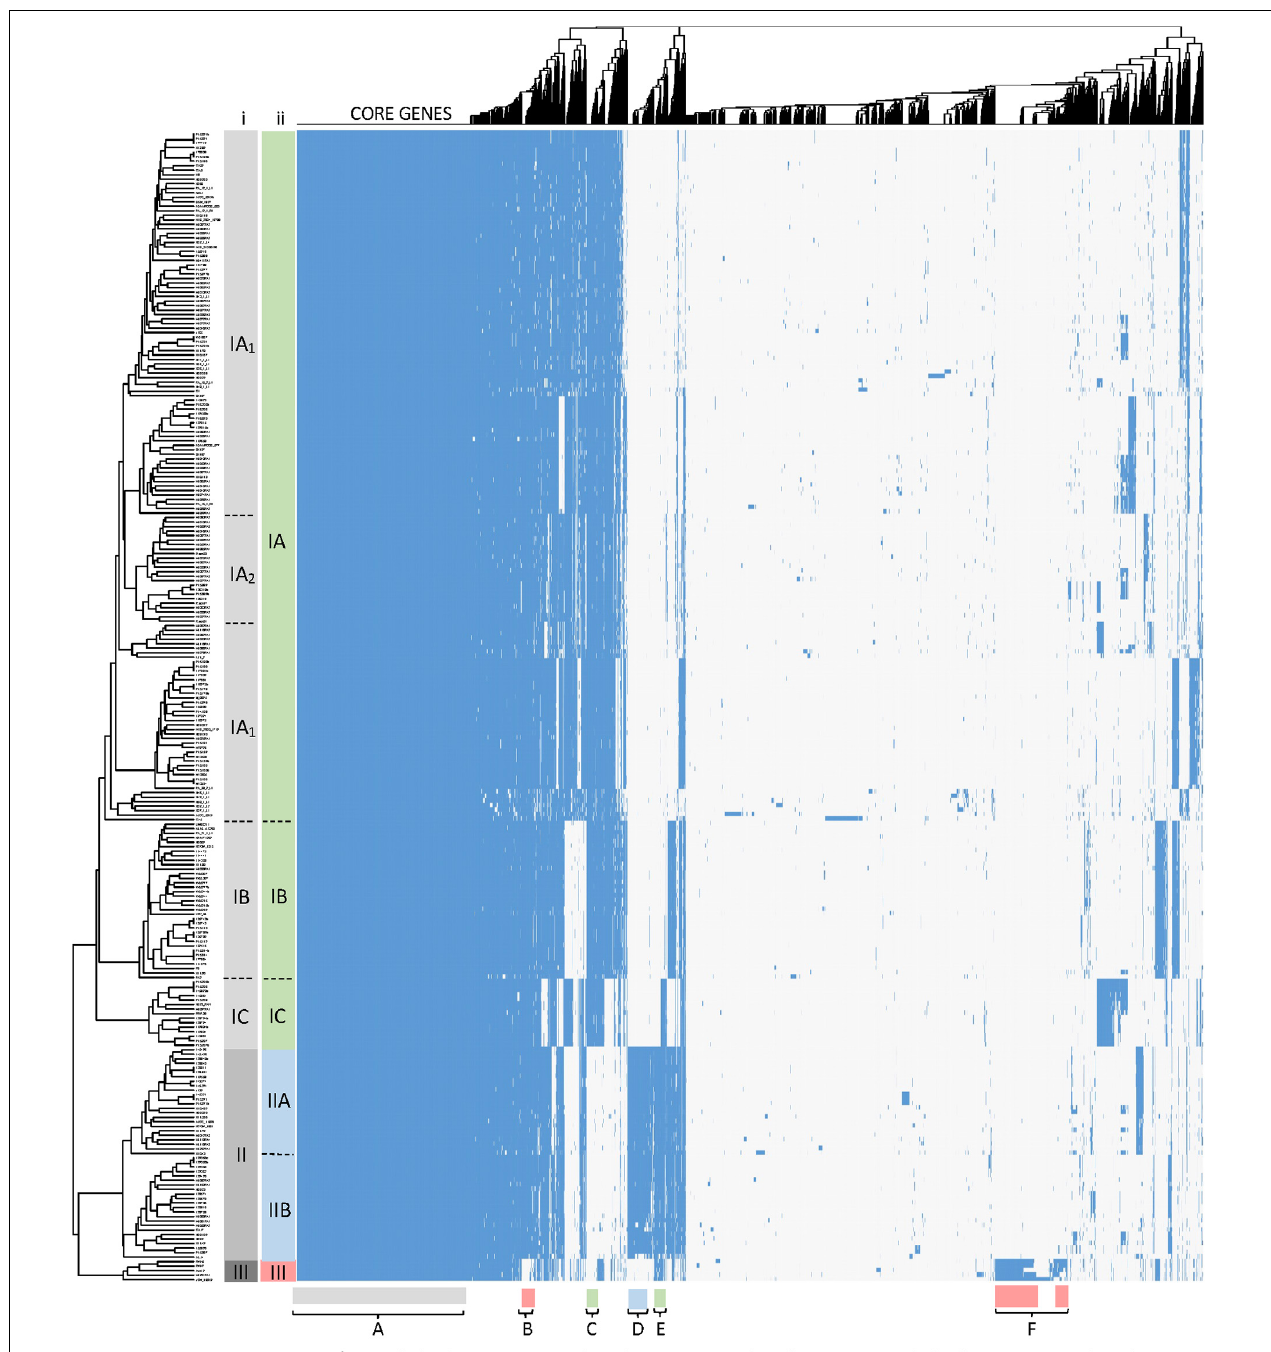
FIGURE 2 | Gene cluster matrix of presence/absence (blue)/(white) of the 6,240 genes (columns) that constitute the pan genome of the 255 C. acnes strains (rows). Hierarchical clustering was performed for both rows and columns and dendrograms were depicted. The main clades and sub-clades of strains are labeled (i) in gray according to the current nomenclature and (ii) color coded for type I, type II and type III, according to our newly proposed classification (see Figure 3 ). Signature gene blocks of each clade are indicated in the bottom.